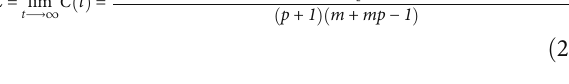
Figure 5: Clustering coe ffi cient C ð t Þ of the model vs. BA model. Simulation data is averaged from 1000